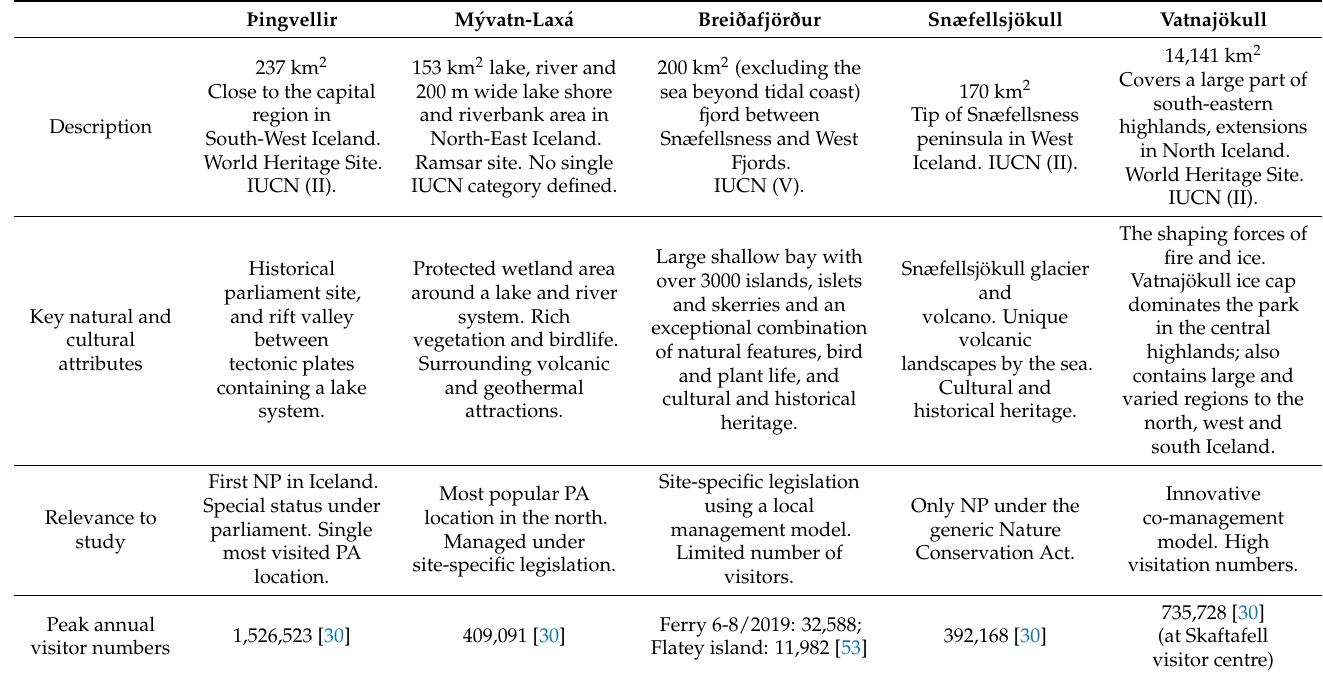
Figure 2. Map of Iceland with the PAs selected for this study. Table 1. Description of selected PAs in the study.